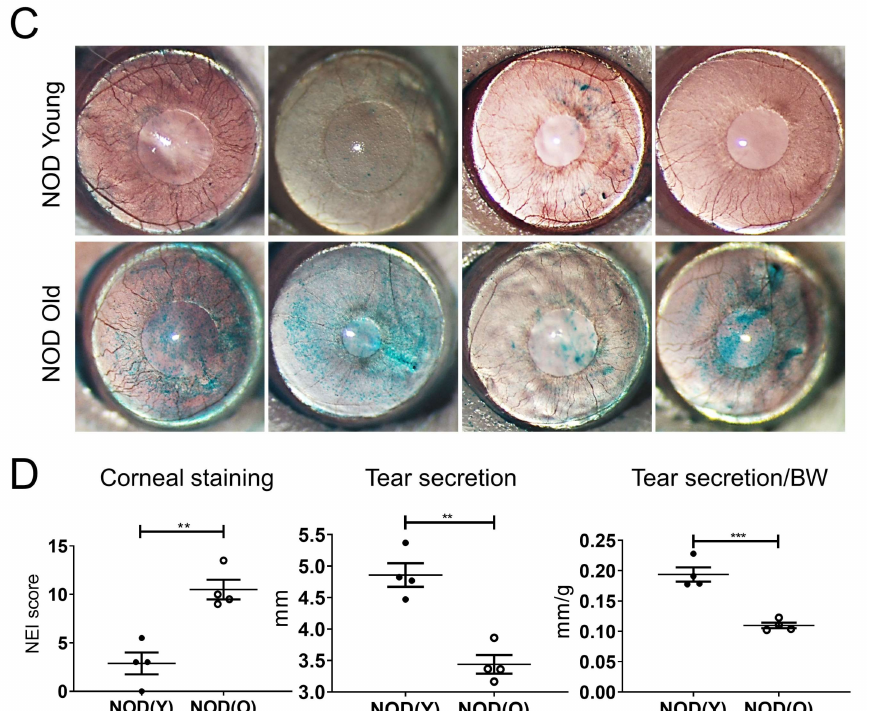
Figure 2. ( A ) Representative images of corneal fluorescein staining of young C57BL/6 (B6) mice (8-week-old; upper row, n = 4) and aged B6 mice (20-month-old; lower low, n = 4). ( B ) The National Eye Institute (NEI) corneal staining score was significantly higher in aged B6 mice than in young B6 mice ( p = 0.013). Body weight (BW) adjusted tear secretion was significantly lower in aged B6 mice than young B6 mice ( p = 0.008). ( C ) Representative images of corneal lissamine green staining of young NOD.B10.H2 b mice (5-week-old; upper row) and aged NOD.B10.H2b mice (24-week-old; lower row). ( D ) The NEI corneal staining score was significantly higher in aged NOD.B10.H2 b mice than in young NOD.B10.H2 b mice ( p = 0.002). Tear secretion and BW-adjusted tear secretion were significantly lower in aged NOD.B10.H2 b mice than in young NOD.B10.H2 b mice ( p < 0.001). Clinical scores were analyzed using unpaired, two-tailed, independent t-test. Data are expressed as the mean ± standard error. Each dot represents average values of either corneal staining scores or tear secretion results from both eyes in each mouse. B6(Y), young B6 mice; B6(O), aged B6 mice; NOD(Y), young NOD.B10.H2 b mice; NOD(O), aged NOD.B10.H2 b mice. * p < 0.05, ** p < 0.01, *** p <